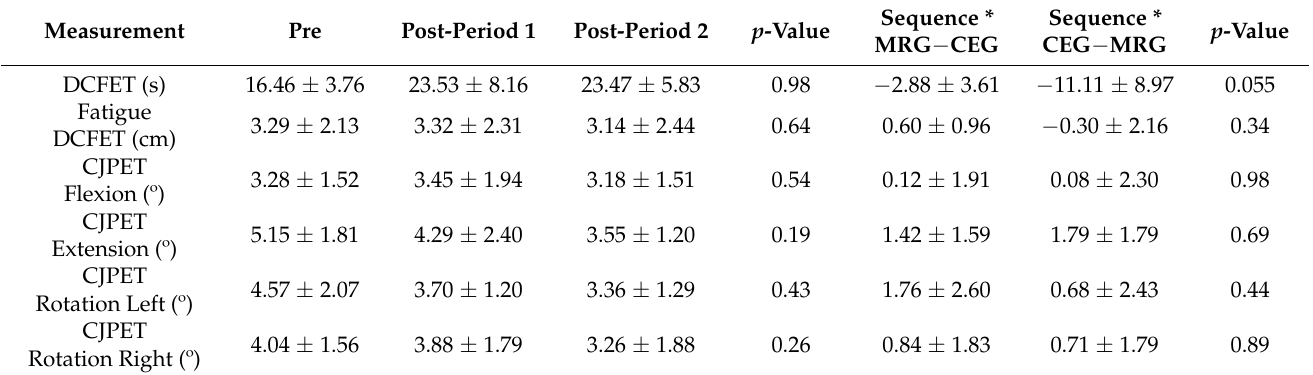
Table 2. Table showing data for the analysis of period and sequence effect. Expressed in mean ±